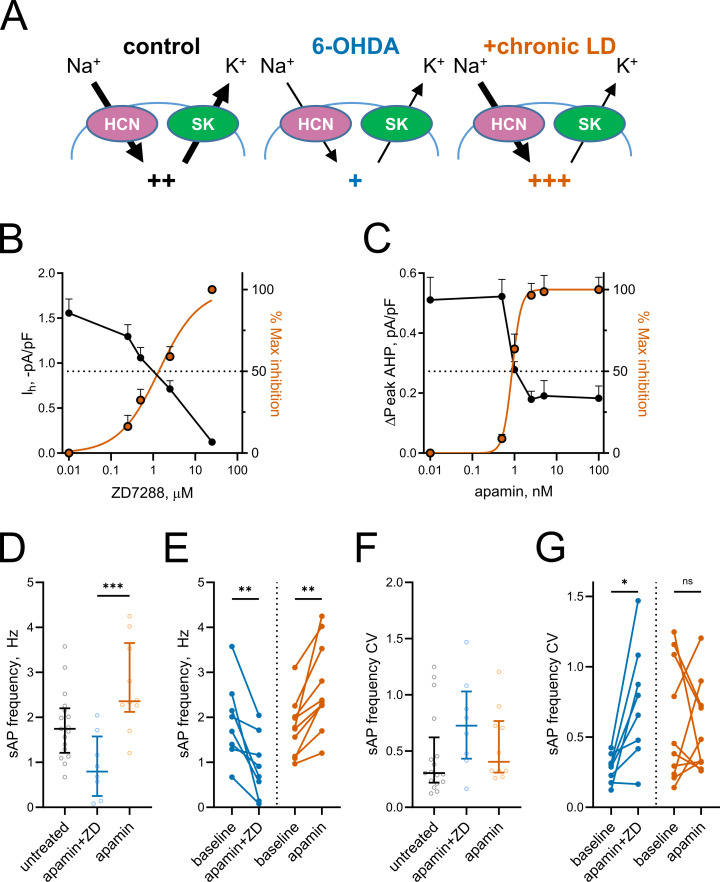
Partial inhibition of HCN and SK channels is sufficient to mimic changes in ChI activity after lesion and chronic L-DOPA treatment.(A) Proposed changes in HCN and SK currents in ChIs from different treatment groups and their effect on spontaneous firing rates (+). (B) Dependence of Ih density (as measured on Figure 3E) on ZD7288 concentration. The orange curve represents fit of the data with the equation Y = 100(XSlope)/(IC50Slope + XSlope). Hill slope and IC50 are 0.9 and 1.4 µM, correspondingly; n = 8 neurons/2 mice. (C) Dependence of mAHP current density (as measured on Figure 4C) on apamin concentration. Hill slope and IC50 are 4 and 0.9 nM, correspondingly; n = 6 neurons/2 mice.(D–G) Partial SK and HCN channel blockade reproduced changes in the sAP rate and coefficient of variation of 6-OHDA and +chronic-LD groups. Although on average the decrease and increase in sAP frequency caused by apamin+ZD and apamin alone, respectively, did not reach statistical significance (D), apamin+ZD reliably decreased and apamin alone increased baseline sAP firing rate in individual ChIs (E). Likewise, the differences in the median coefficient of variation did not reach statistical significance (F), however, apamin+ZD increased CV over baseline for most ChIs, whereas apamin alone did not change the baseline CV (G). Untreated n = 17 neurons/6 mice, apamin+ZD n = 8 neurons/3 mice, apamin n = 10 neurons/3 mice; In panel D, p<0.001 (***) by Kruskal-Wallis test with Dunn’s multiple comparisons. In panels E and G, p<0.05 (*) and p<0.01 (**), Wilcoxon matched-pairs signed rank test.Figure 5—source data 1.Individual neuron data and statistics for all panels.